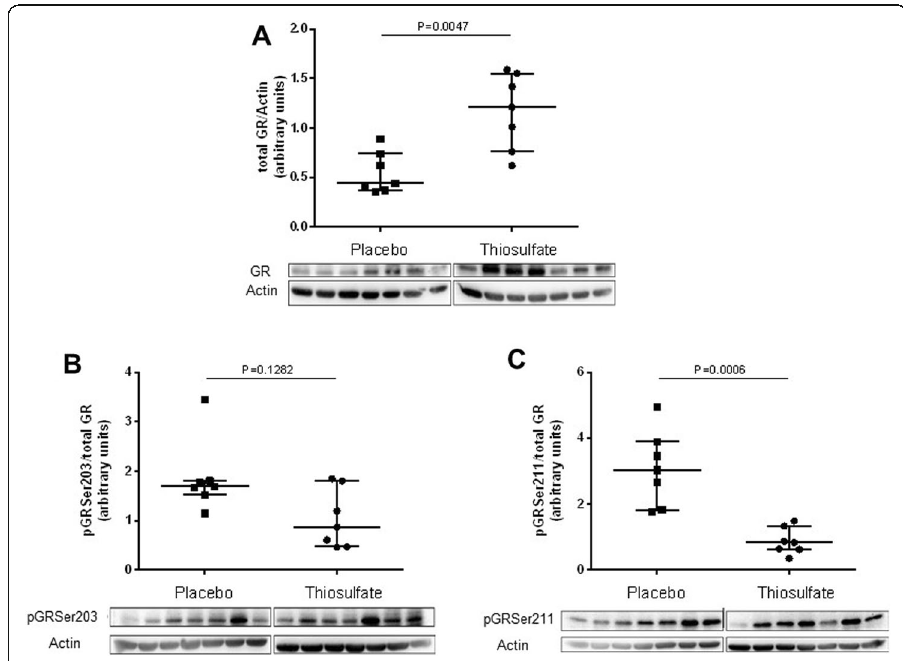
Fig. 5 a Protein expression of the total glucocorticoid receptor (GR). b Protein expression of phosphorylated GR at serine 201 (pGRser203) and c phosphorylated GR at serine 211 (pGRser211) in lung tissue. a , b , and c are normalized to actin as loading control and thereafter to total GR. In a , b , and c , the lung tissue was analyzed from swine resuscitated from hemorrhagic shock and treated with sodium thiosulfate or placebo for the first 24 h of resuscitation after hemorrhagic shock [78]. Data is presented as median and interquartile